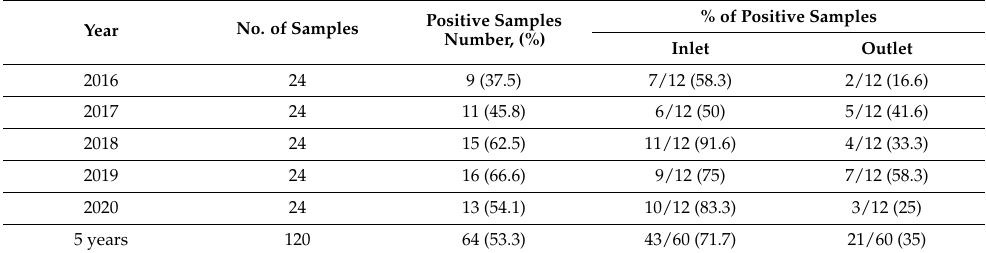
Table 3. Incidence of HAdV in sewage samples in Egypt from 2016 to